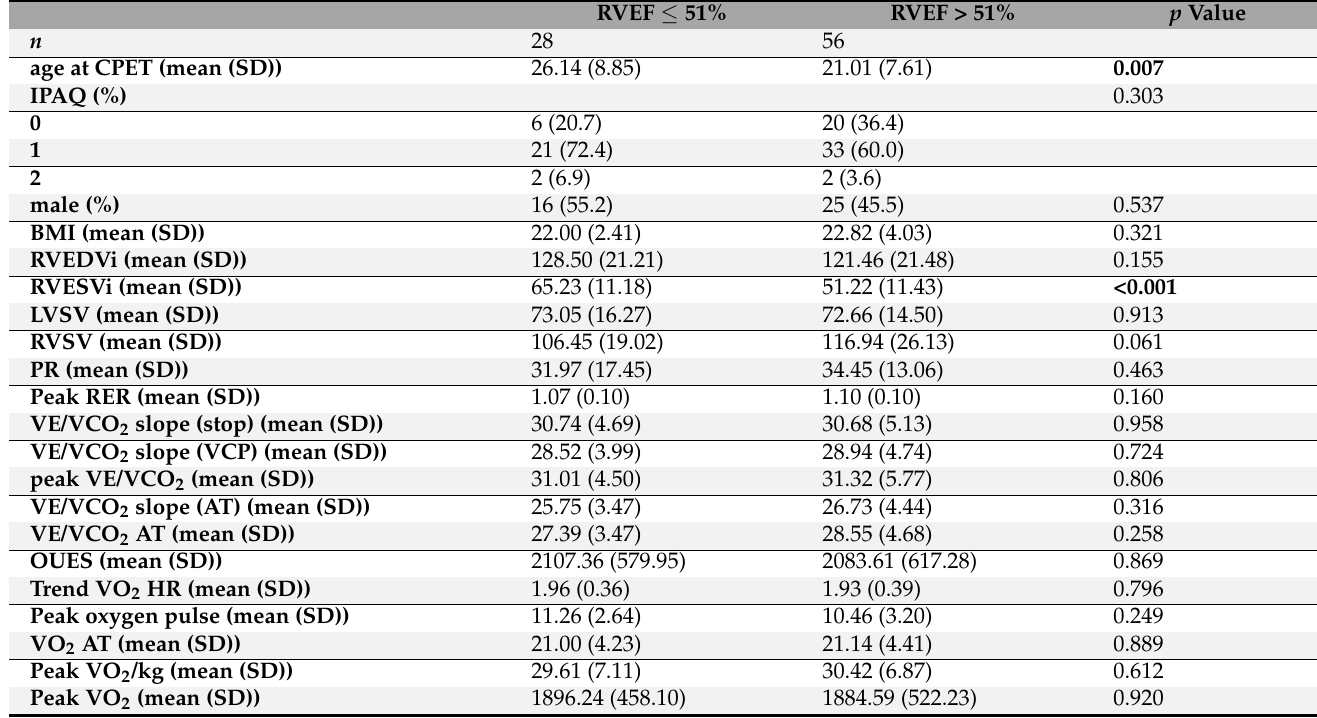
Table 2. Comparison between rToF patients with normal right ventricular ejection fraction (RVEF) and rToF patients with reduced RVEF for clinical, cardiac magnetic resonance (CMR), and cardiopul- monary exercise testing (CPET)